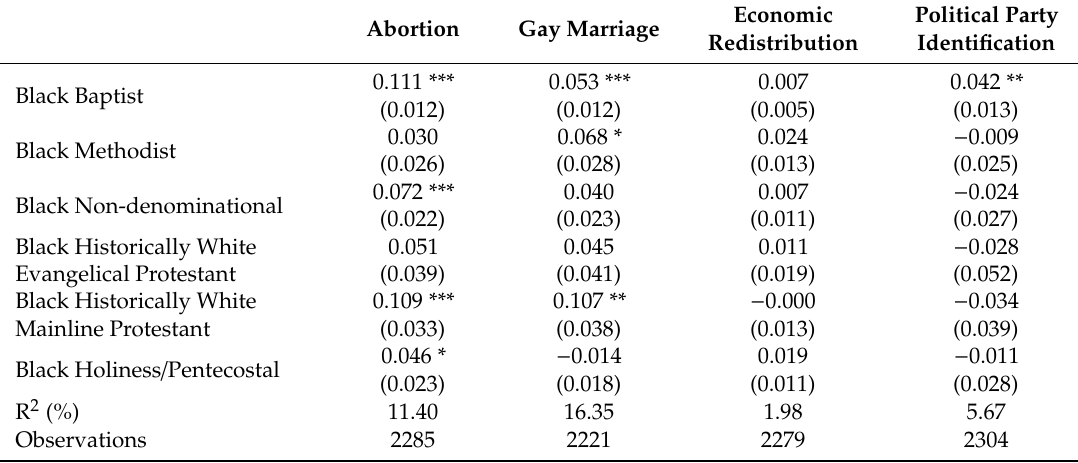
Table 3. E ff ects of education in OLS models with the interaction of education and Black religious a ffi liation on political